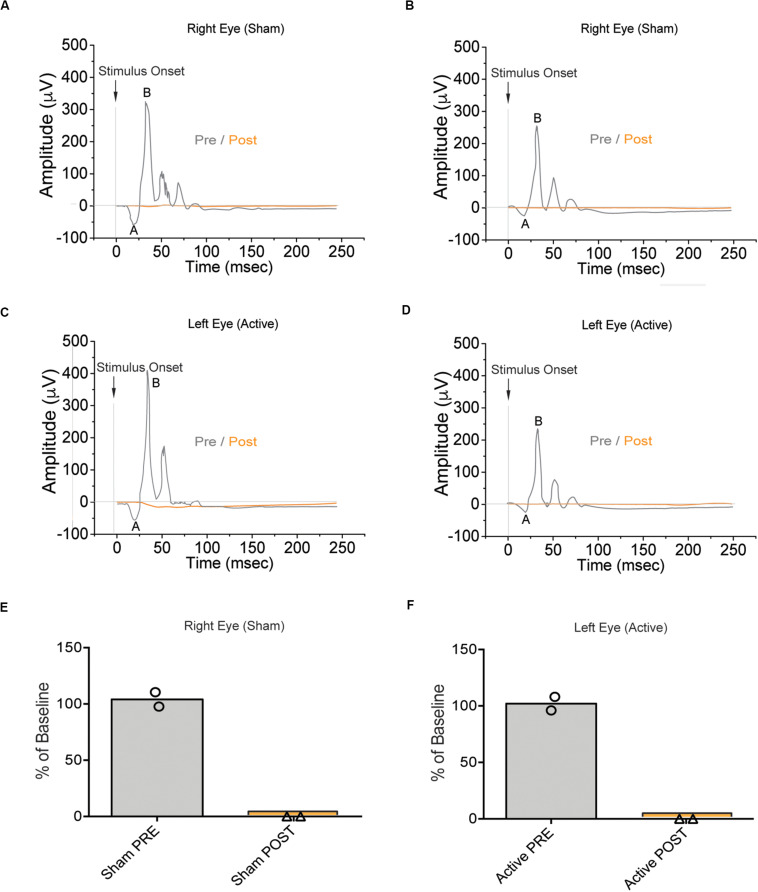
Electroretinographic responses in naïve pigs subretinally implanted with the ESF-based substrate. (A,B) Representative ff-ERG signals of the right eye of the E2 (left) and E3 (right) pigs before surgery (Pre, gray) and after (Post, orange) implantation of the sham ESF substrate alone. (C,D) Representative ff-ERG signals of the left eye of the E2 (left) and E3 (right) pigs before surgery (Pre, gray) and after (Post, orange) implantation of the ESF-based complete polymeric device (active). (E,F) Bar plots (means with superimposed experimental points) depicting the amplitude of the ff-ERGs b-wave before (Pre, gray) and after (Post, orange) the implantation of either sham substrate (right eye; E) or the active device (left eye; F) in the E2 and E3 pigs (n = 2). Data are expressed as the percentage of baseline. The use of ESF as a substrate, irrespective of whether it was layered with the polymers or bare-implanted, had a detrimental impact on the visual response to light after implantation.